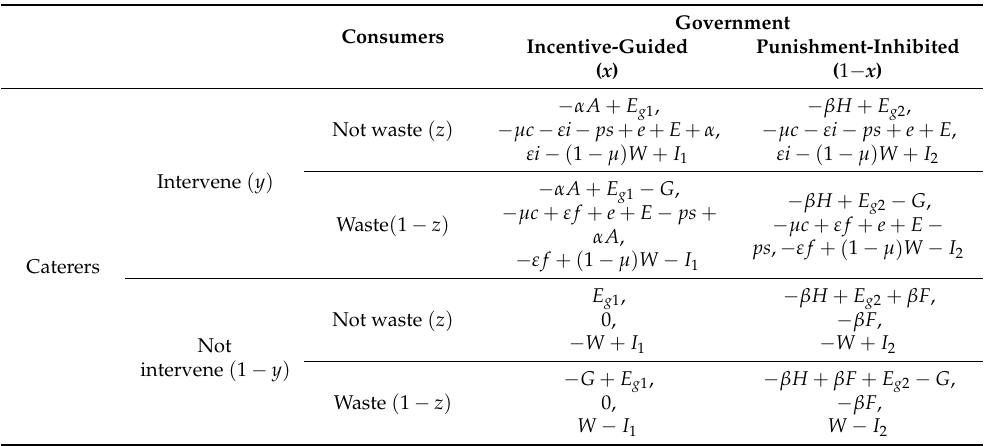
Table 1. Players’ payoff